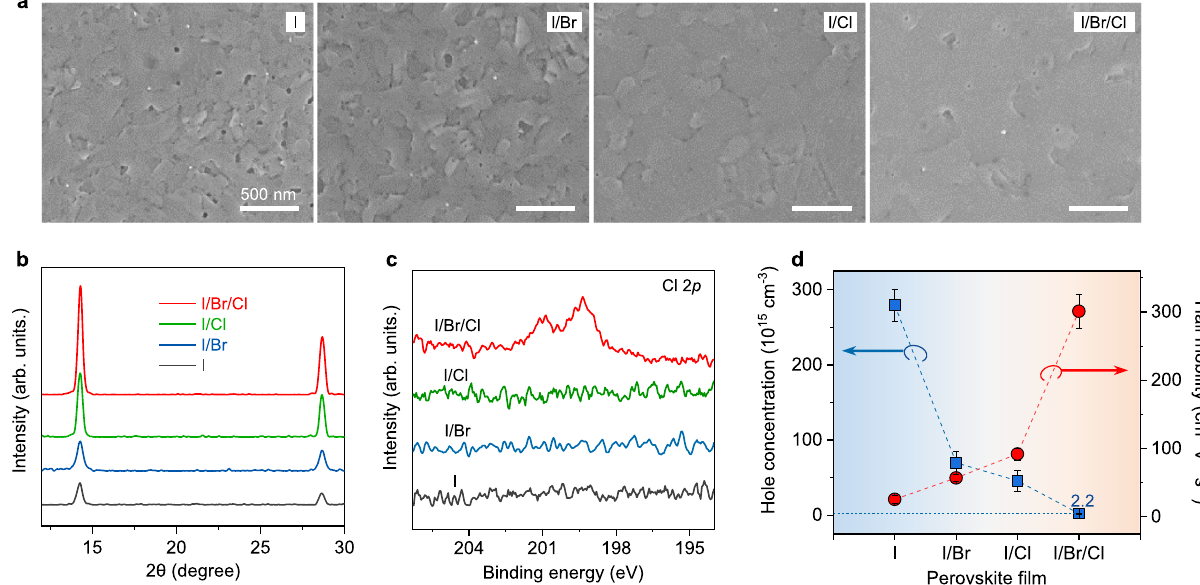
Fig. 2 Characterisation of MASnX 3 fi lms. a SEM images, b XRD patterns, c Cl 2 p core level XPS spectra, and d Hall mobilities and hole concentrations of the different perovskite fi lms. The error bars present standard errors calculated from fi ve fi lms per